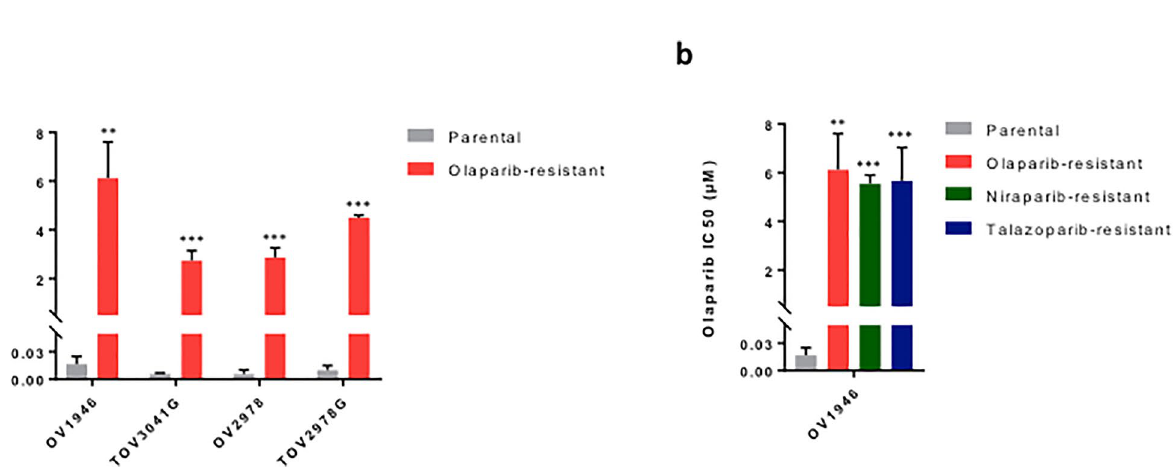
Figure 1. Olaparib sensitivity of the acquired resistance cell lines. Bar graphs comparing the olaparib IC 50 values, evaluated by clonogenic assays, of each of the olaparib-resistant (-or) cell lines to that of their parental counterparts ( a ), and the olaparib IC 50 values of the niraparib- and talazoparib-resistant (-nr, -tr) OV1946 cell lines compared to parental OV1946 ( b ). Experiments were repeated three times. Error bars represent SEM.